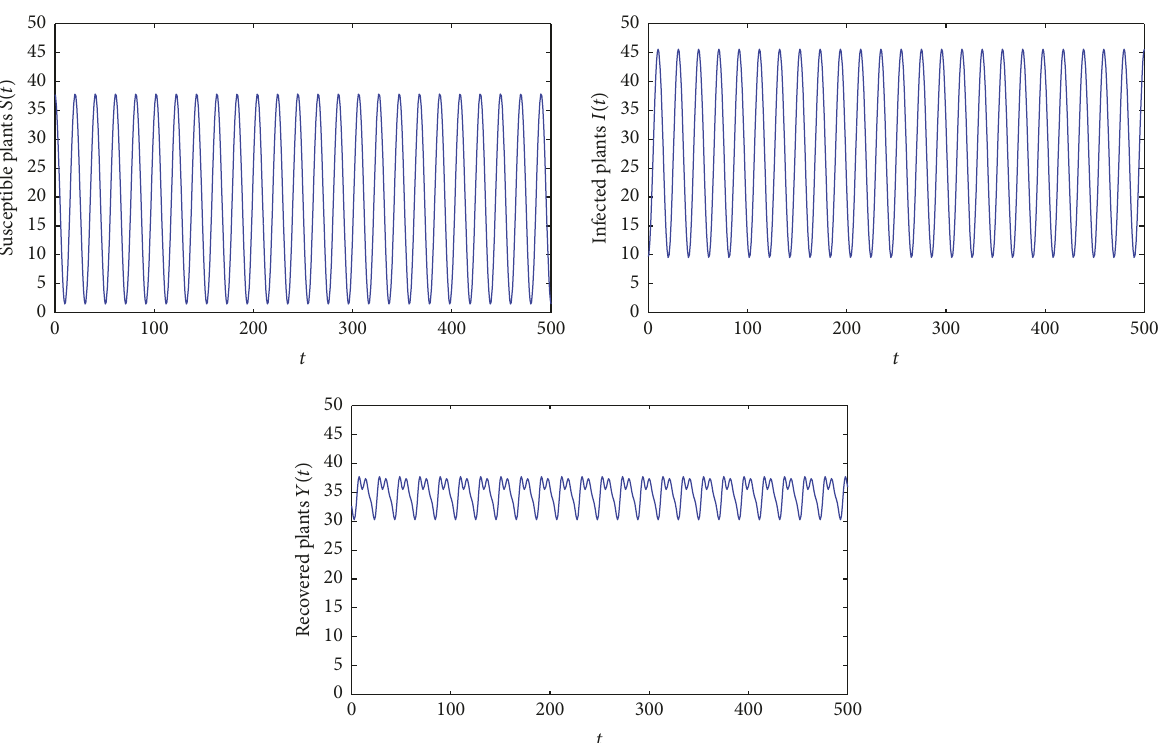
Figure 4: System (3) undergoes a Hopf bifurcation at the endemic equilibrium 𝐸 ∗ , where 𝜏 1 = 7.6 > 𝜏 10 = 7.4719 and 𝜏 2 = 2